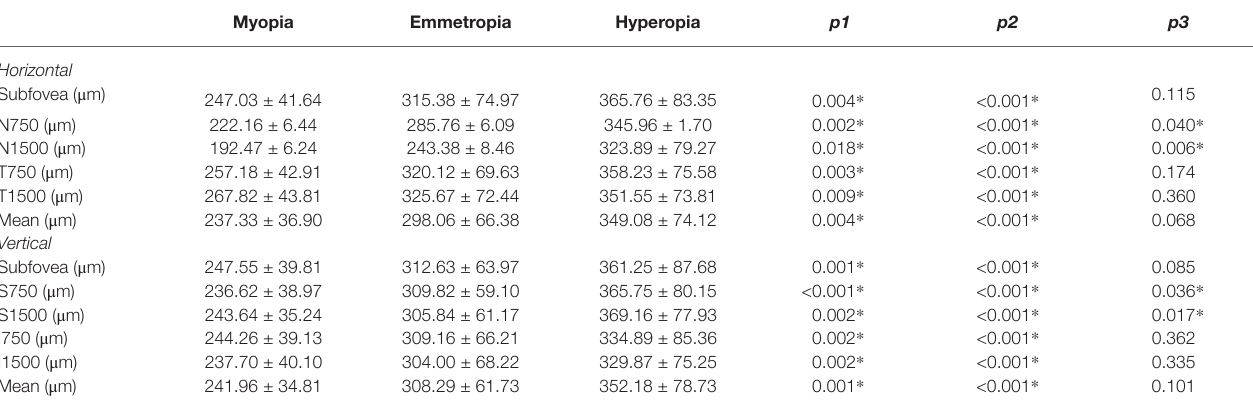
TABLE 2 | Baseline choroidal thickness (CT) comparisons among myopia, emmetropia, and hyperopia groups. Myopia Emmetropia